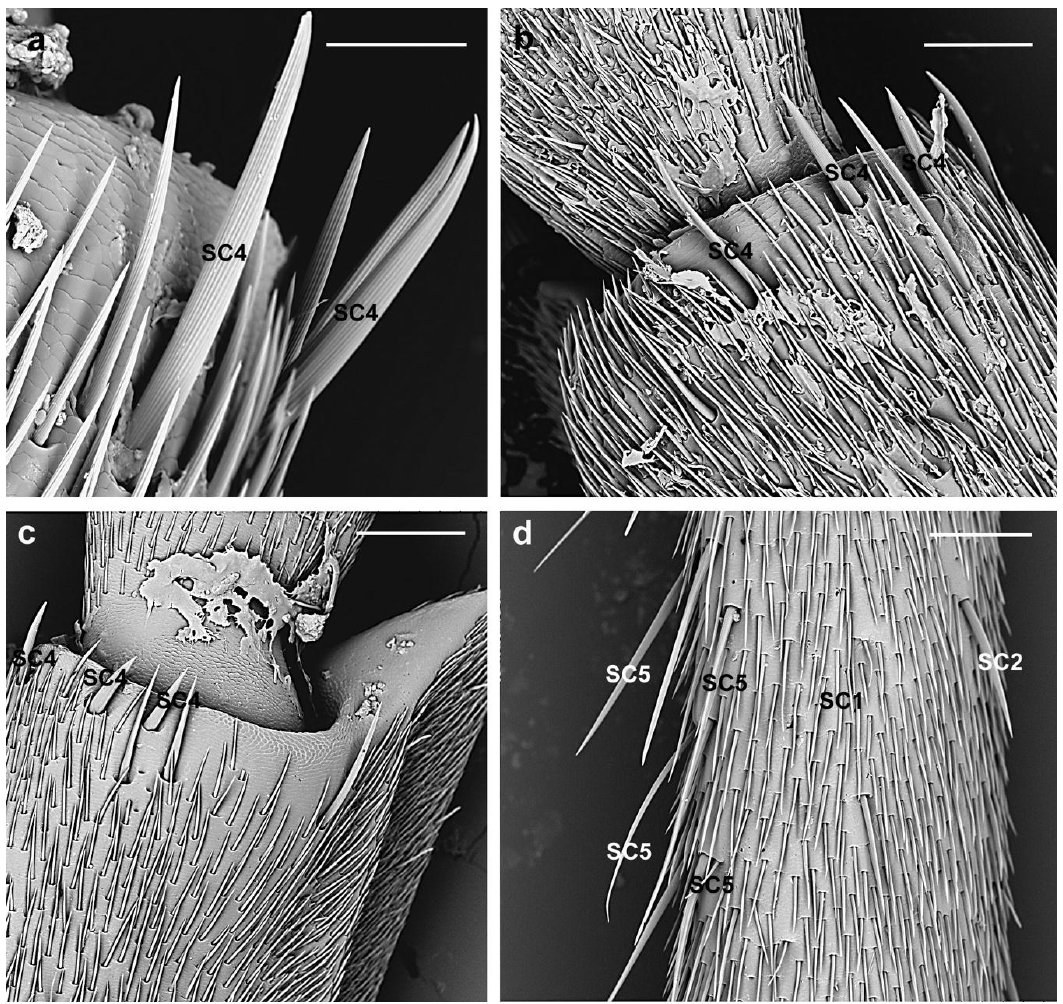
Figure 6. A. bungii female, SEM. Sensilla chaetica SC4 and SC5. ( a ) Details of SC4: Articulated bristles, with longitudinal grooves. ( b , c ) Several SC4 arranged in horizontal line on the distal region of the flagellomeres. ( d ) SC5 provided with long, straight, grooved shafts. Abbreviations: SC1, sensillum chaeticum type 1; SC2, sensillum chaeticum type 2; SC4, sensillum chaeticum type 4; SC5, sensillum chaeticum type 5. Scale bars: 50 µm ( a ); 100 µm ( b ); and 150 µm ( c , d ).